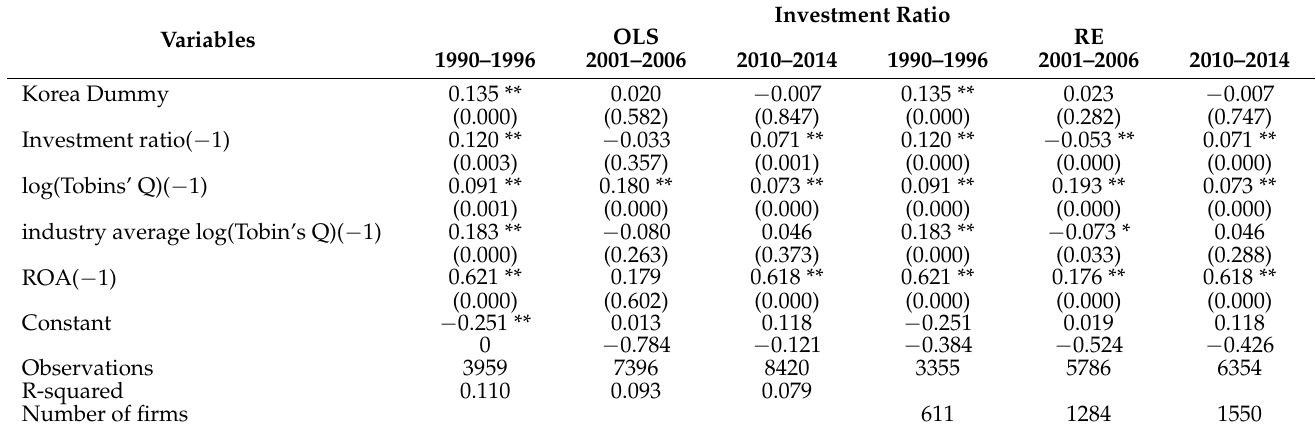
Table 2. Comparison of investment ratio by regression.